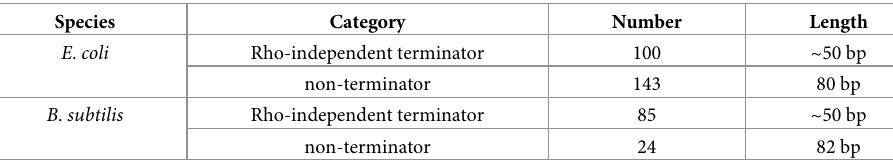
Table 2. Independent